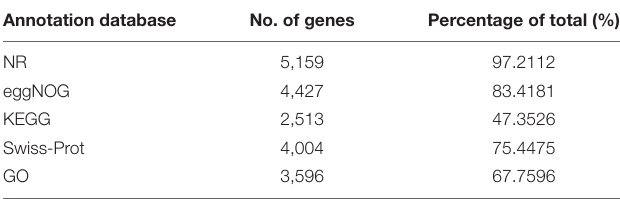
TABLE 4 | Functions of the protein-coding genes of B. aryabhattai